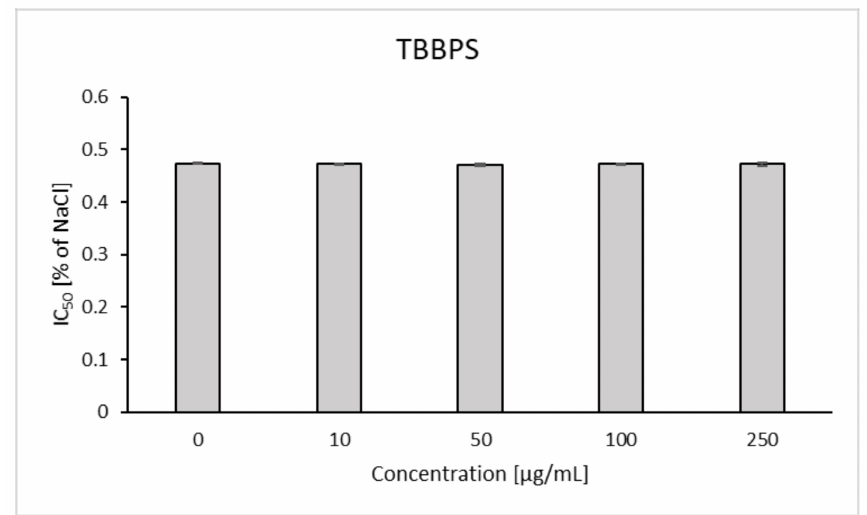
Figure 12. IC 50 parameter for control erythrocytes and erythroctes incubated with TBBPS at 10–250 µ g/mL for 3